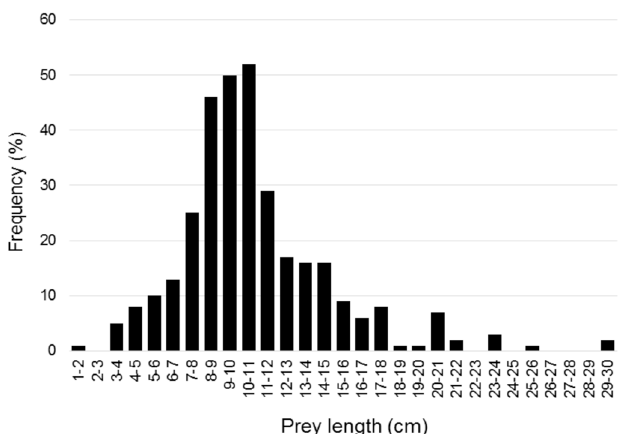
Fig. 2. Overall prey fi sh-size distribution expressed as percent number in stomach contents of